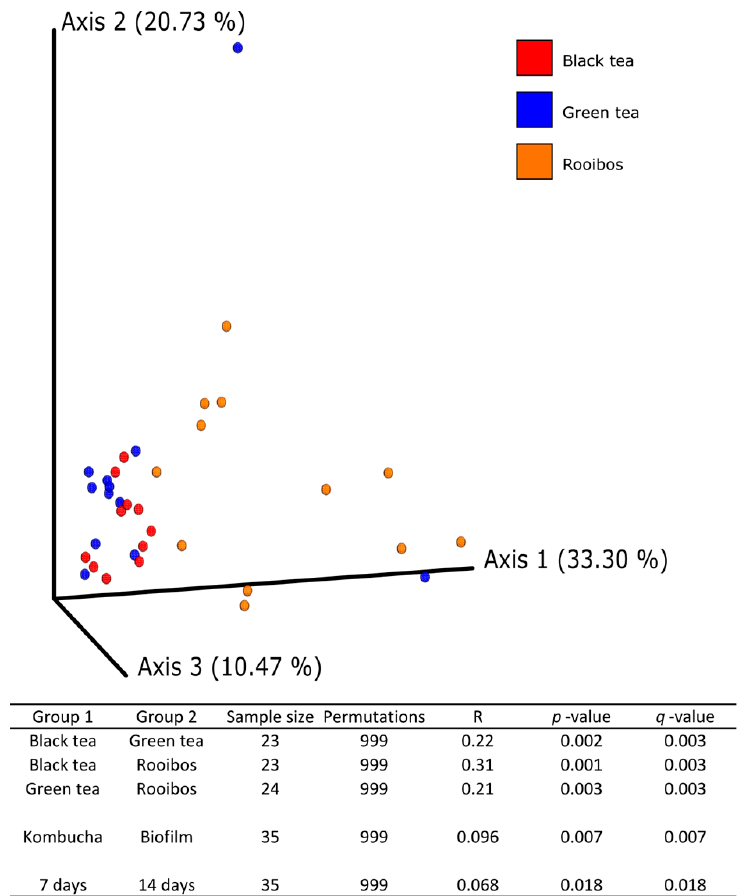
Figure 4. The influence of substrate (plot, table), matrix (only table) and fermentation time (only on kombucha fungal community structure after 14 days of fermentation illustrated as a PCoA plot of Bray-Curtis dissimilarity index determined by ITS2 gene amplicon sequencing (pairwise ANOSIM, 999 permutations).